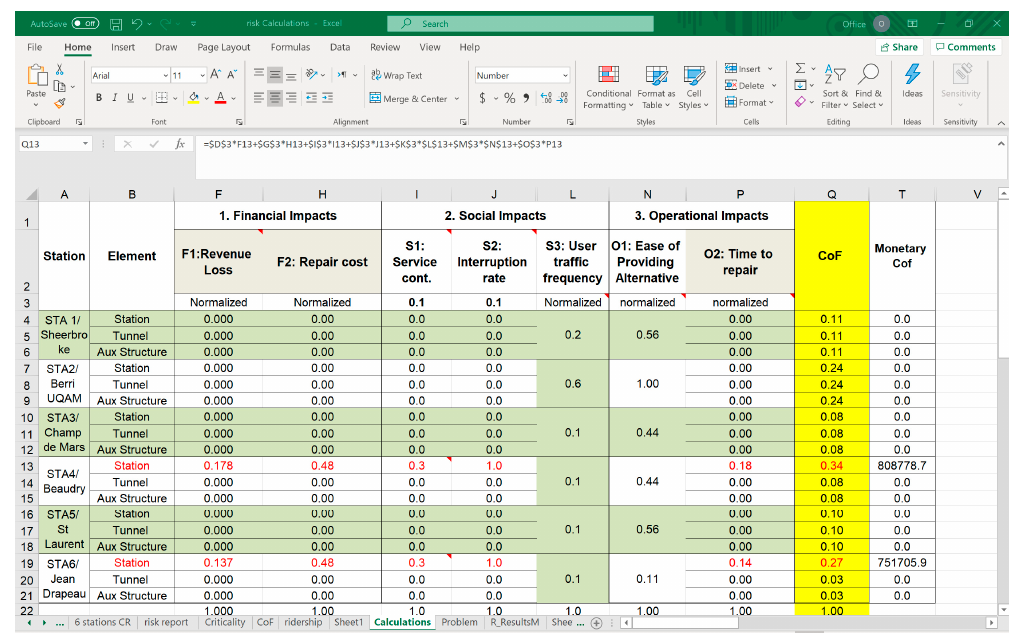
Figure 2. Failure impacts Calculation Sheet. Table 2. Local and Global Weights of Failure impacts Module.